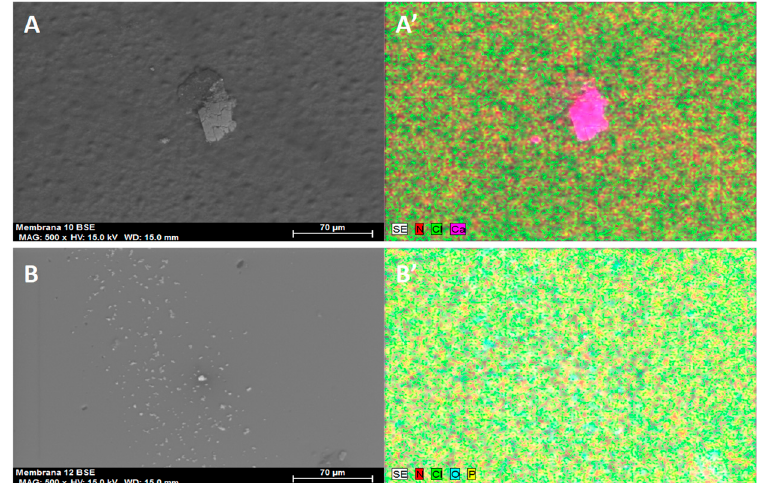
Figure 7. SEM of membranes containing 70% w / w of IL after being used as separators for each feeding solution: CaCl 2 ( A ) and Na 2 HPO 4 ( B ), and elemental mapping: CaCl 2 ( A’ ) and Na 2 HPO 4 ( B’ ).